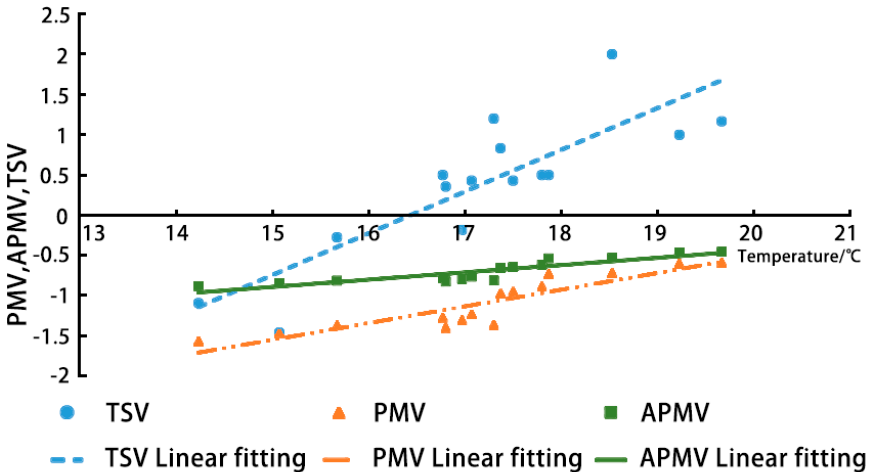
Figure 14. Linear fit of TSV, PMV, and aPMV values (source: self-drawn). The linear fits of TSV, PMV, and aPMV values to the operating temperature ( T a ) were obtained after fitting 15 sets of sample polling values at different temperatures.